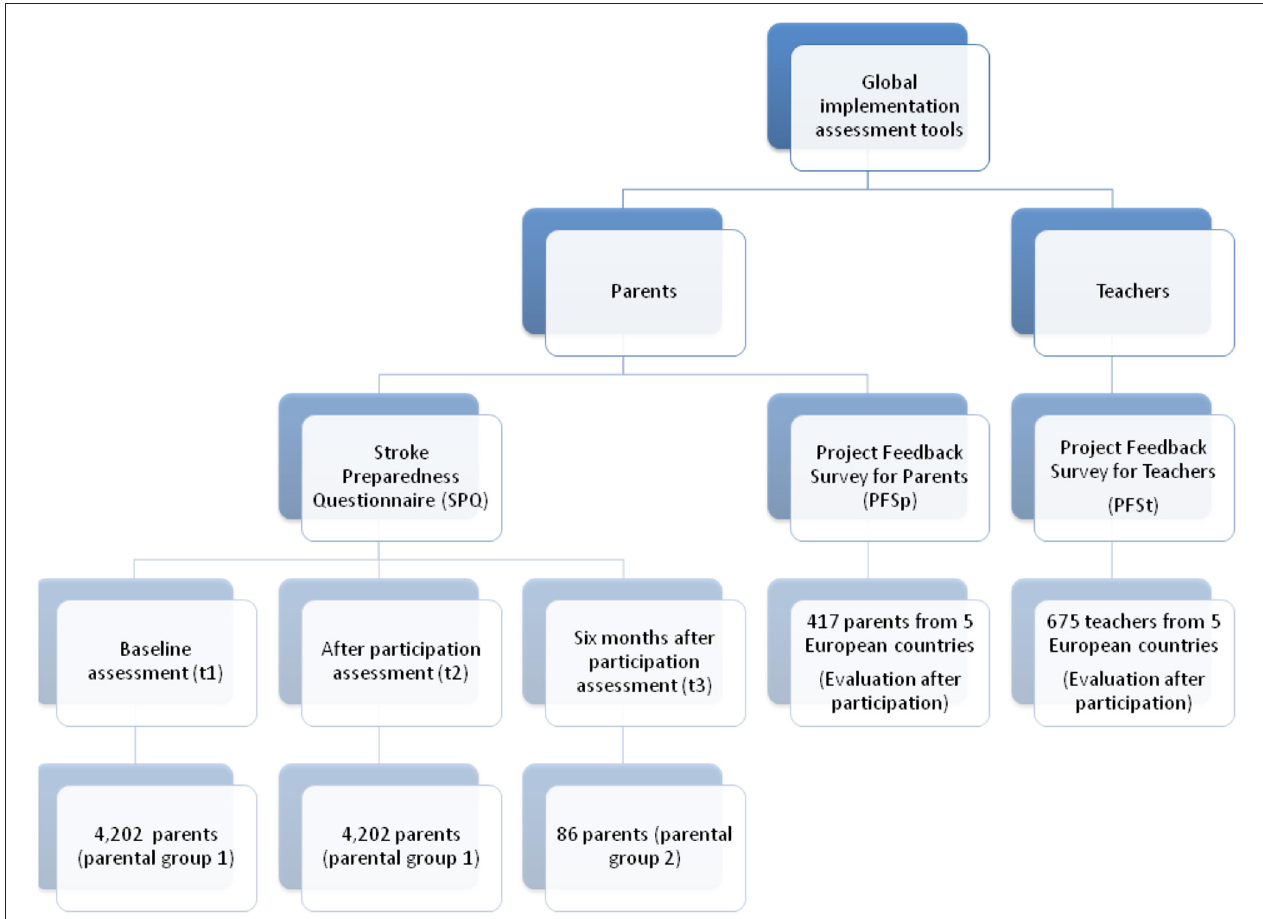
FIGURE 1 | Flowchart describing the assessment tools used for parents and teachers’